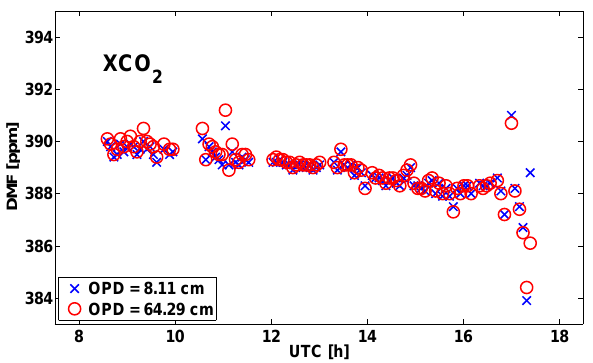
Fig. 8. Retrieved XCO 2 from observations by the high resolution instrument IFS125HR for the 16 April 2009. The red symbols cor- respond to the high resolution of 0.014cm − 1 , the blue symbols to a resolution of 0.11cm − 1 .